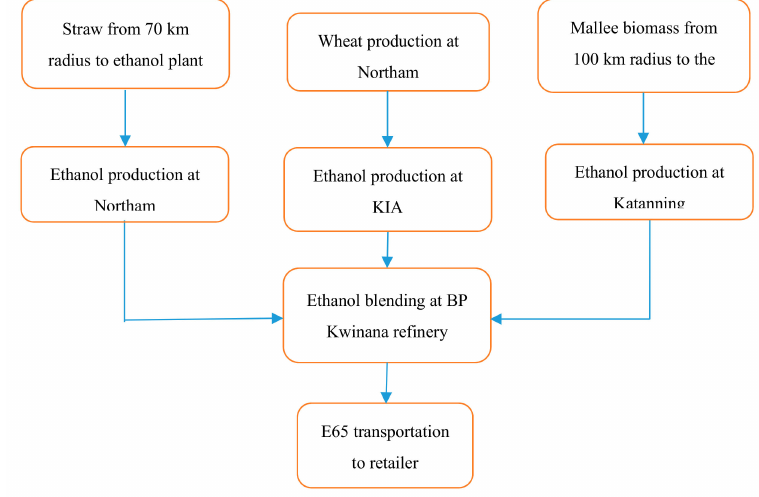
Figure 1. The ethanol (E65) supply